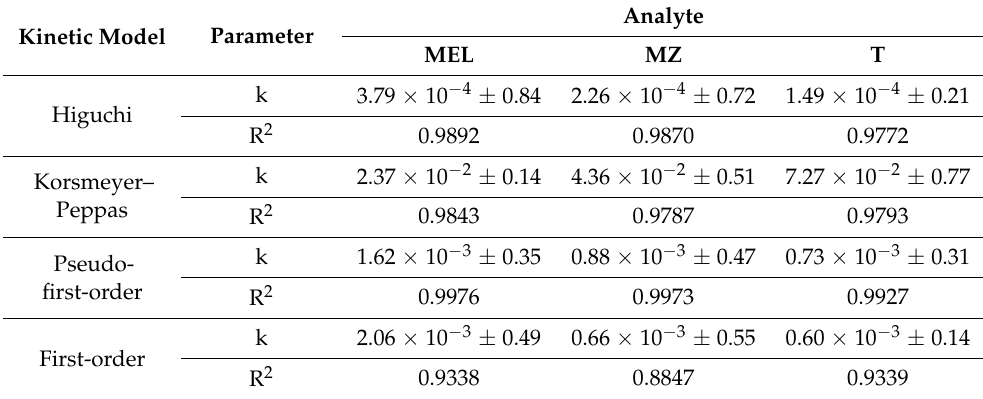
Table 3. The kinetic constants obtained by linear fitting for the studied